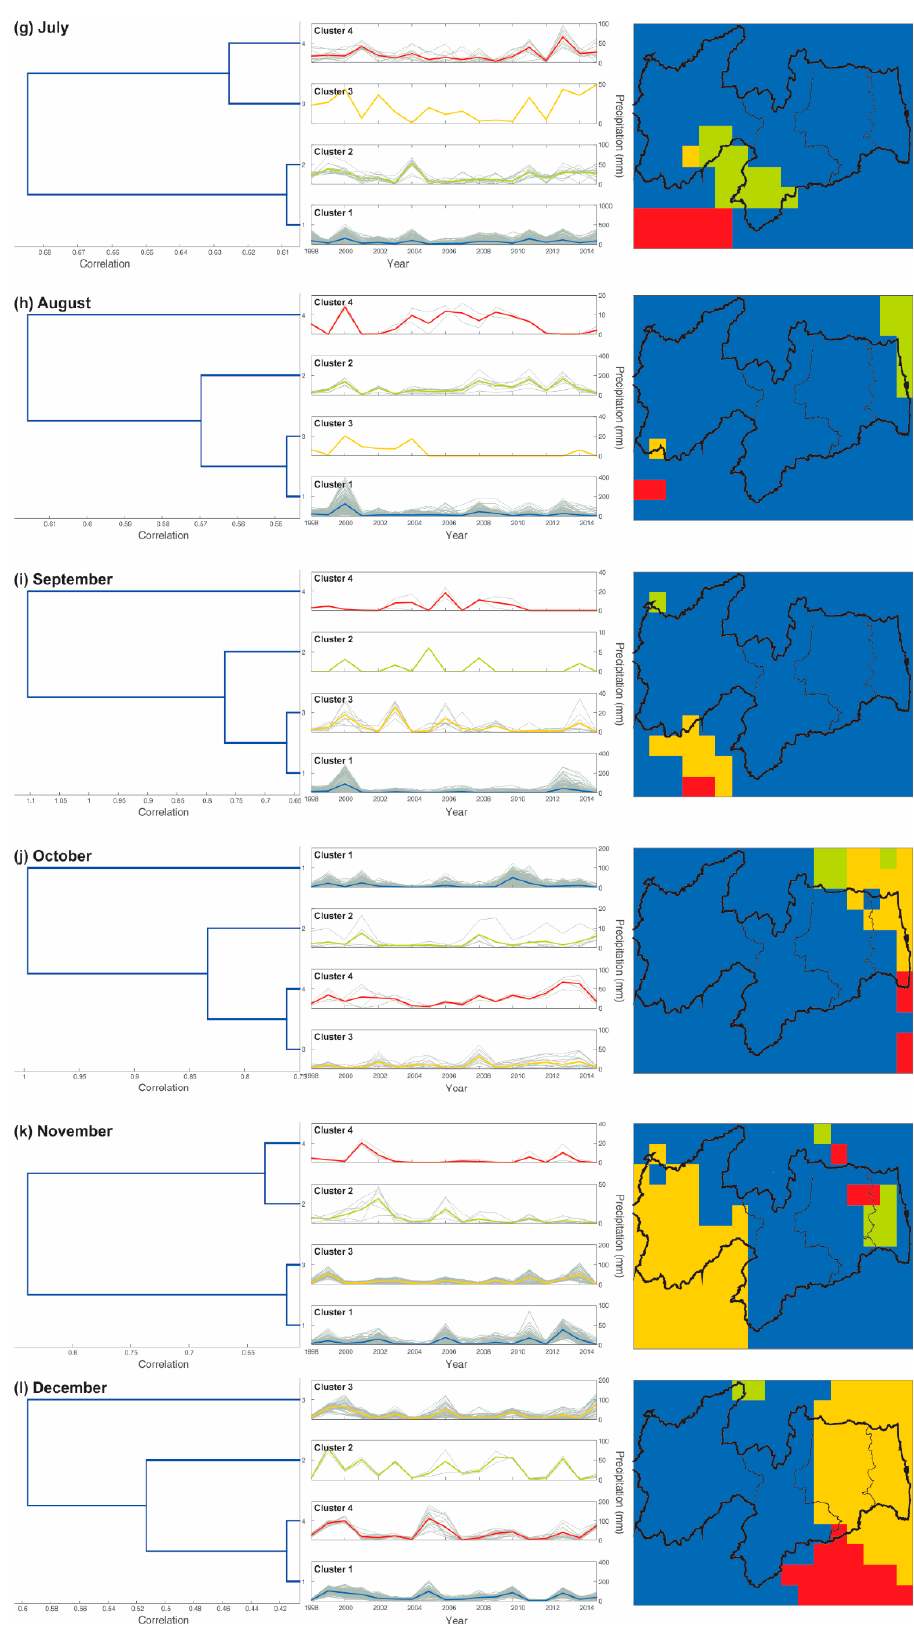
Figure 6. Cluster spatializations in four clusters and dendrograms of mean monthly precipitation time series for each month over Paraíba state (1998–2015).